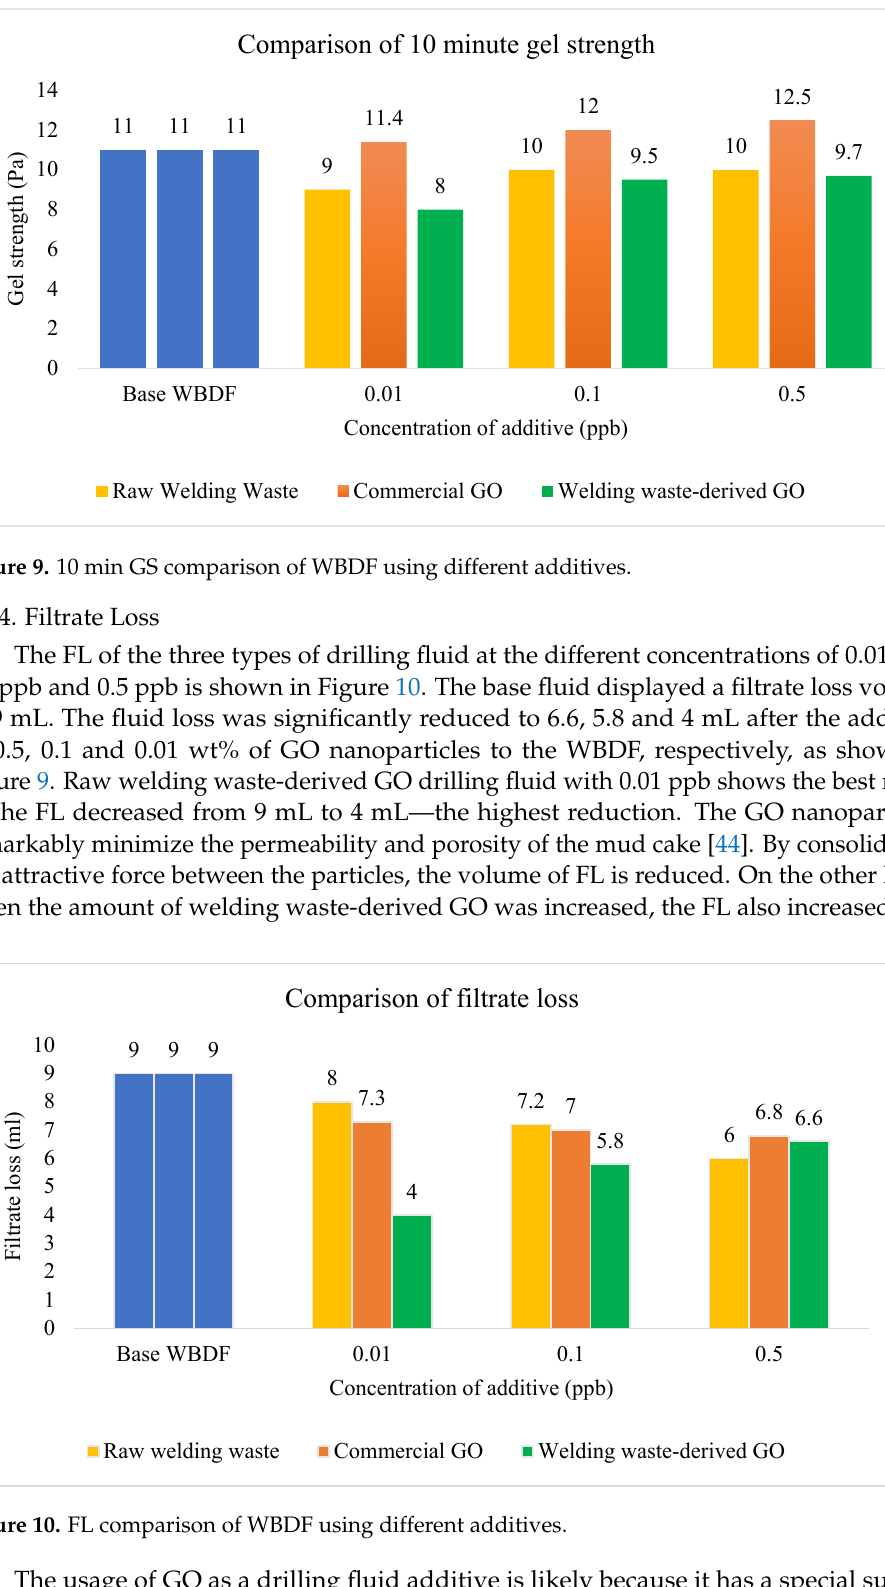
Figure 8. 10 s GS comparison of WBDF using different additives.